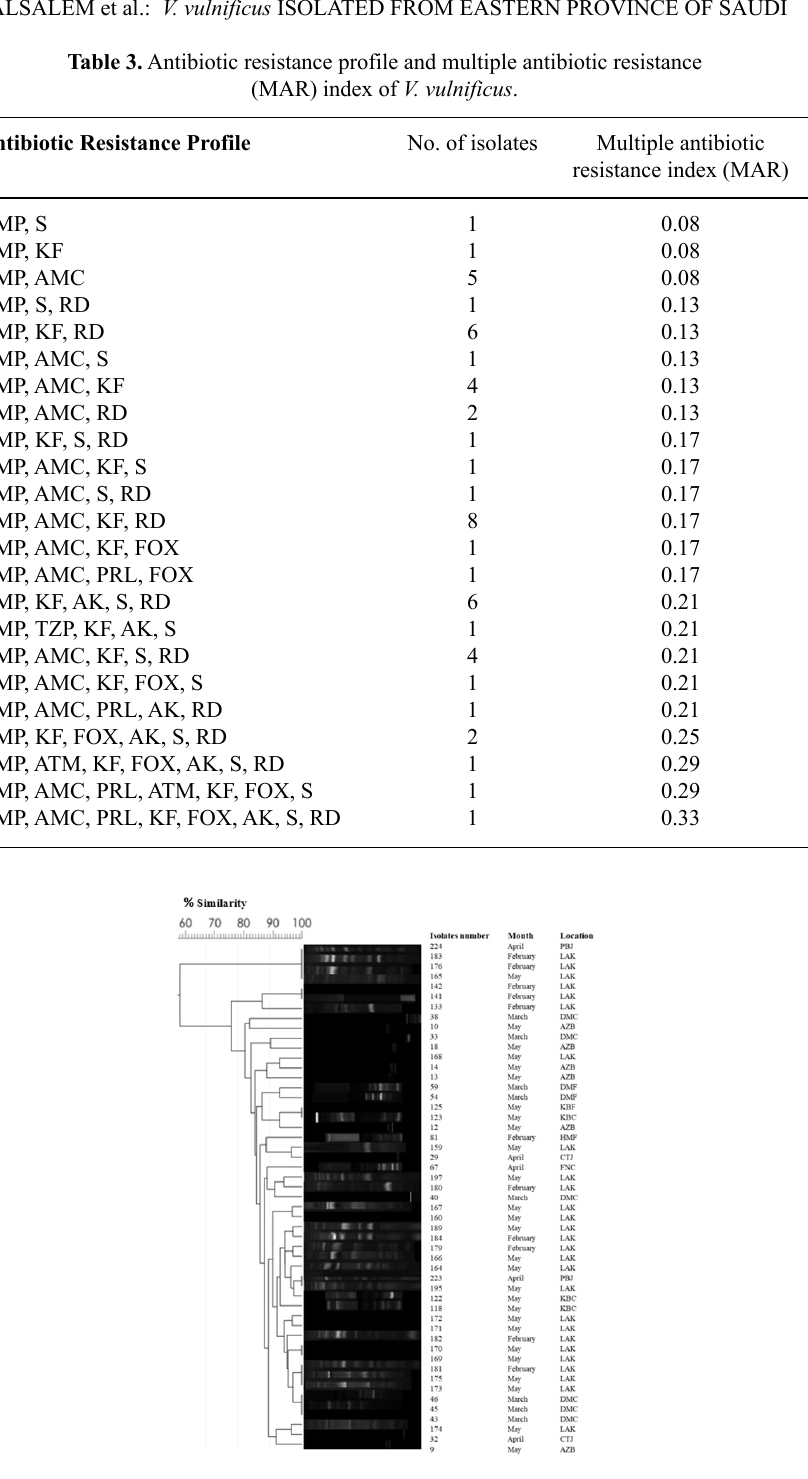
Fig. 4. Cluster generated by ERIC-PCR fingerprints of 51 isolates of V. vulnificus grouped by the ERIC1R primer according to their genetic similarities using the UPGMA algorithm. The fingerprints genetic similarities between the isolates were calculated using the Dice